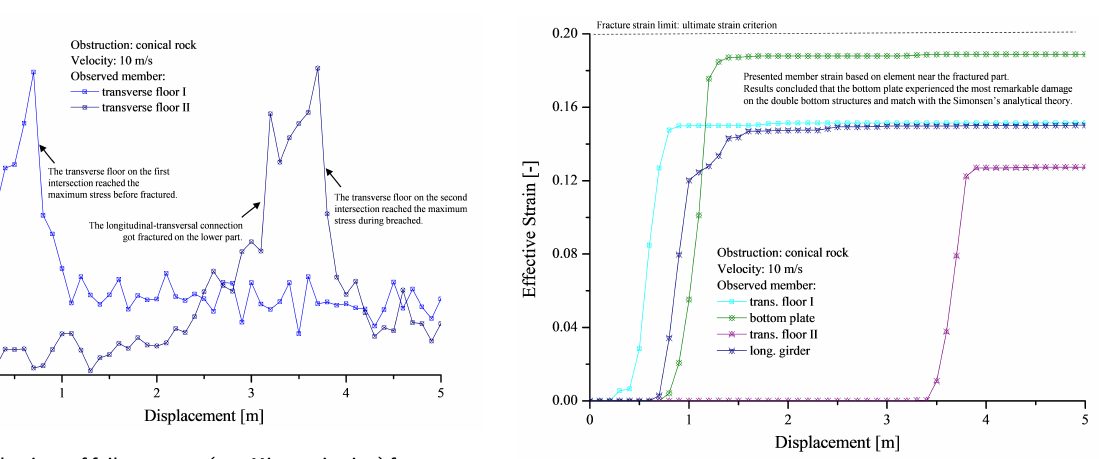
Figure 9: Behaviour of failure stress (von Mises criterion) for transversal members on the double bottom.